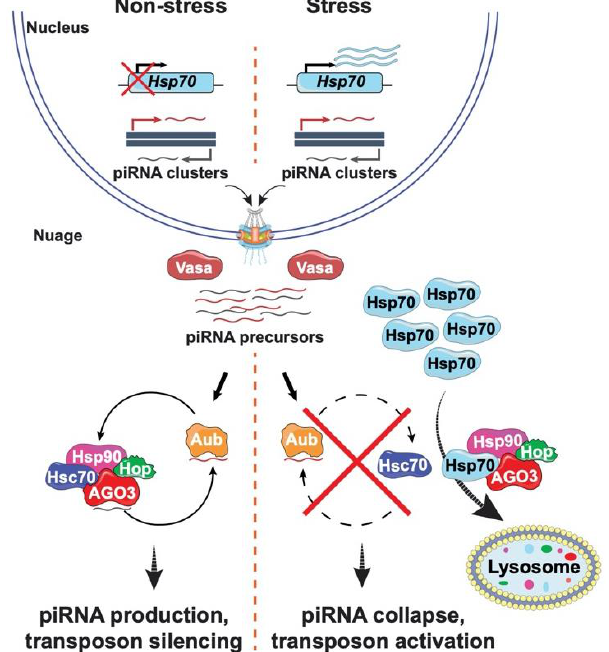
Figure 2. Transposon silencing collapses under stress conditions. Left: piRNA production occurs in the absence of stress. Precursor piRNAs are synthesized in the nucleus, transported into the nuage, where they are loaded onto the PIWI proteins. Aubergine (Aub) binds antisense piRNAs (red) that cleave transposon mRNAs to generate sense piRNAs (black) that are loaded onto a second PIWI protein AGO3. This cycle continues, thereby amplifying levels of piRNAs. Right: Under stress conditions, transcription of Hsp70 increases, increasing levels of HSP70, a protein that interacts with the HSP90/83 co-chaperone complex and relocalizes Hsp90, Hop, and AGO3 from the nuage to the lysosome for degradation. As a result, stress causes collapase of piRNA synthesis and promotes transposon activation. Icons used in this figure were modified from bioicons (bioicons.com);